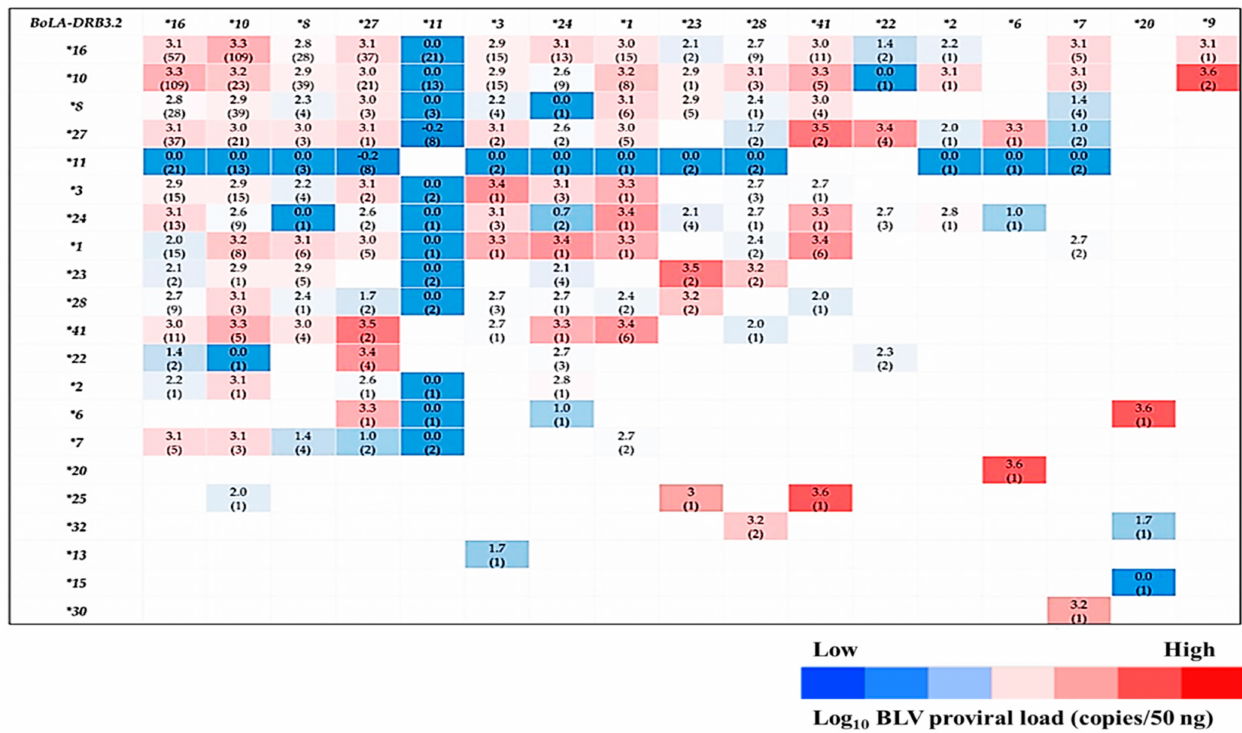
Figure 4. Heat map showing the mean log 10 values for BLV PVLs (copies/50 ng) and different BoLA-DRB3 allele combina- tions. Numbers in each cell indicate the mean values of the different allele combinations, numbers in (): sample numbers for each allele combination. The dark-colored cells show the LPLs in BLV infections and the light-colored cells show the HPLs in these infections. Blank cells represent no samples for this